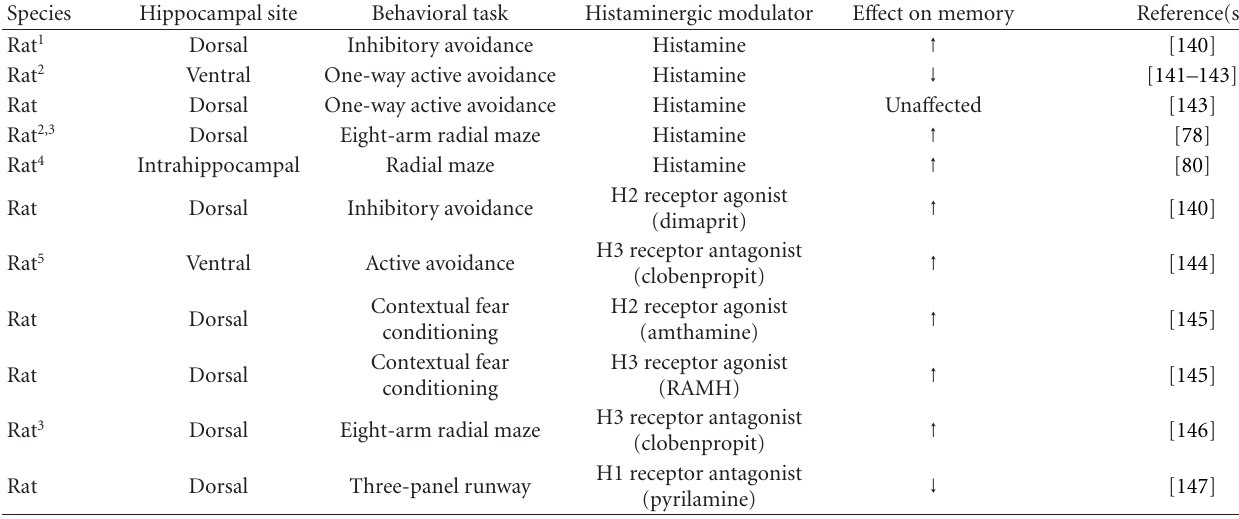
Table 4: Intrahippocampal administration of drugs that act on the histaminergic system and memory performance. Species